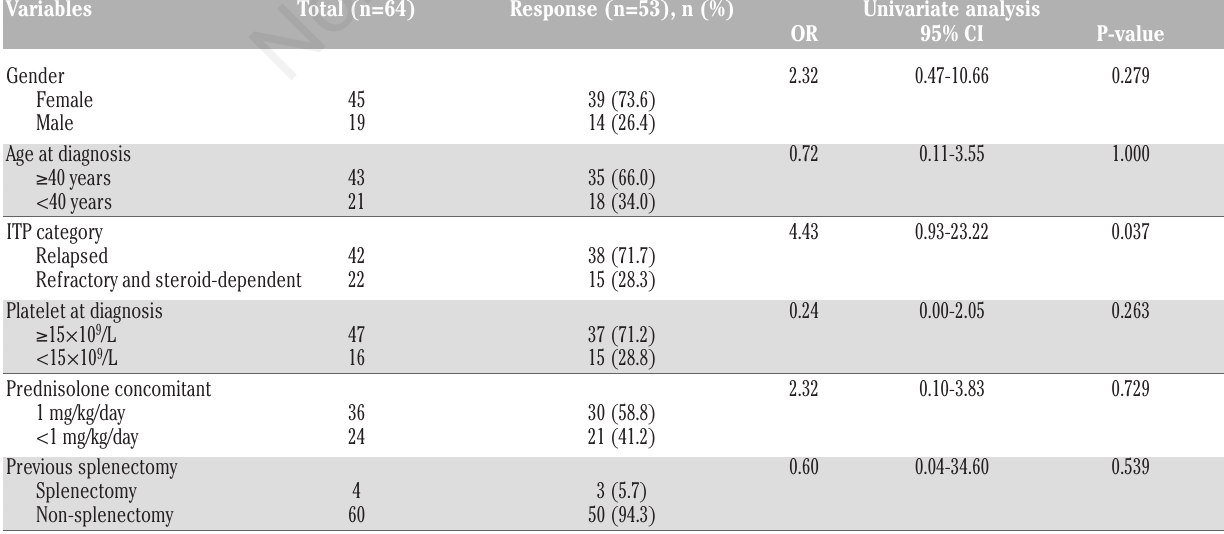
Table 3. Correlation of risk factors and treatment response.